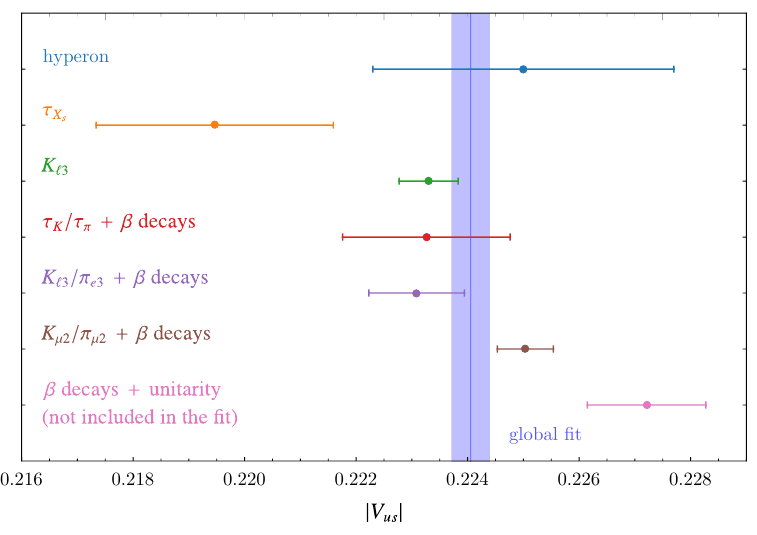
Figure 2 . Summary of the determinations of | V us | from various processes. The global fit value of | V us | is obtained in eq. (2.11). Note that the global fit does not include the CKM unitarity